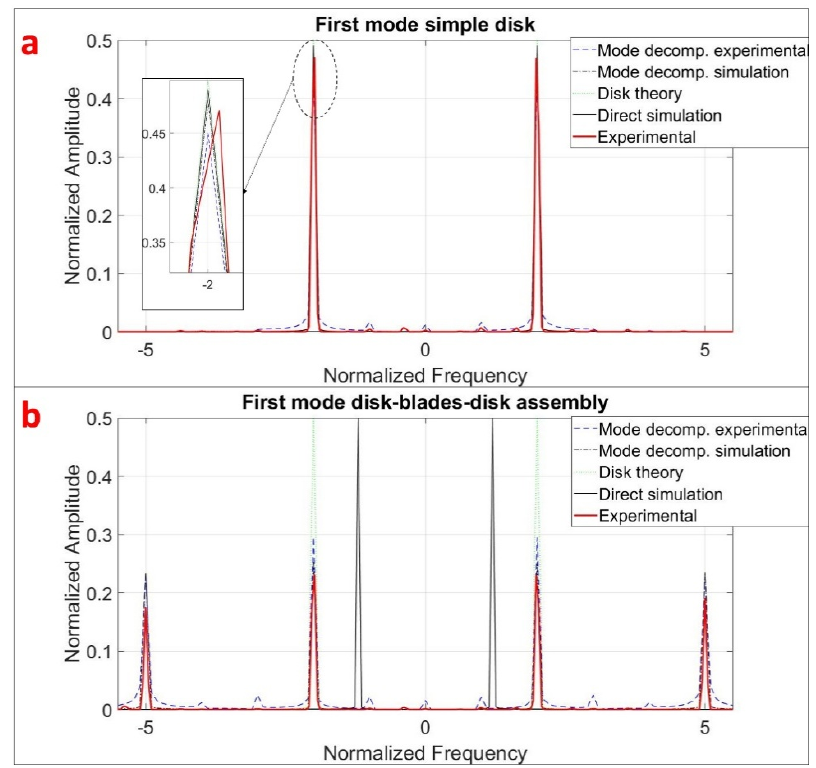
Figure 17. Peak prediction (direct simulation (ANSYS), mode shape decomposition method (experimental and numerical mode shape), simple disk theory) and experimental results for the stationary frame and mode shape with main component n = 2 : ( a ) simple disk structure [19], and ( b ) disk-blades-disk assembly.